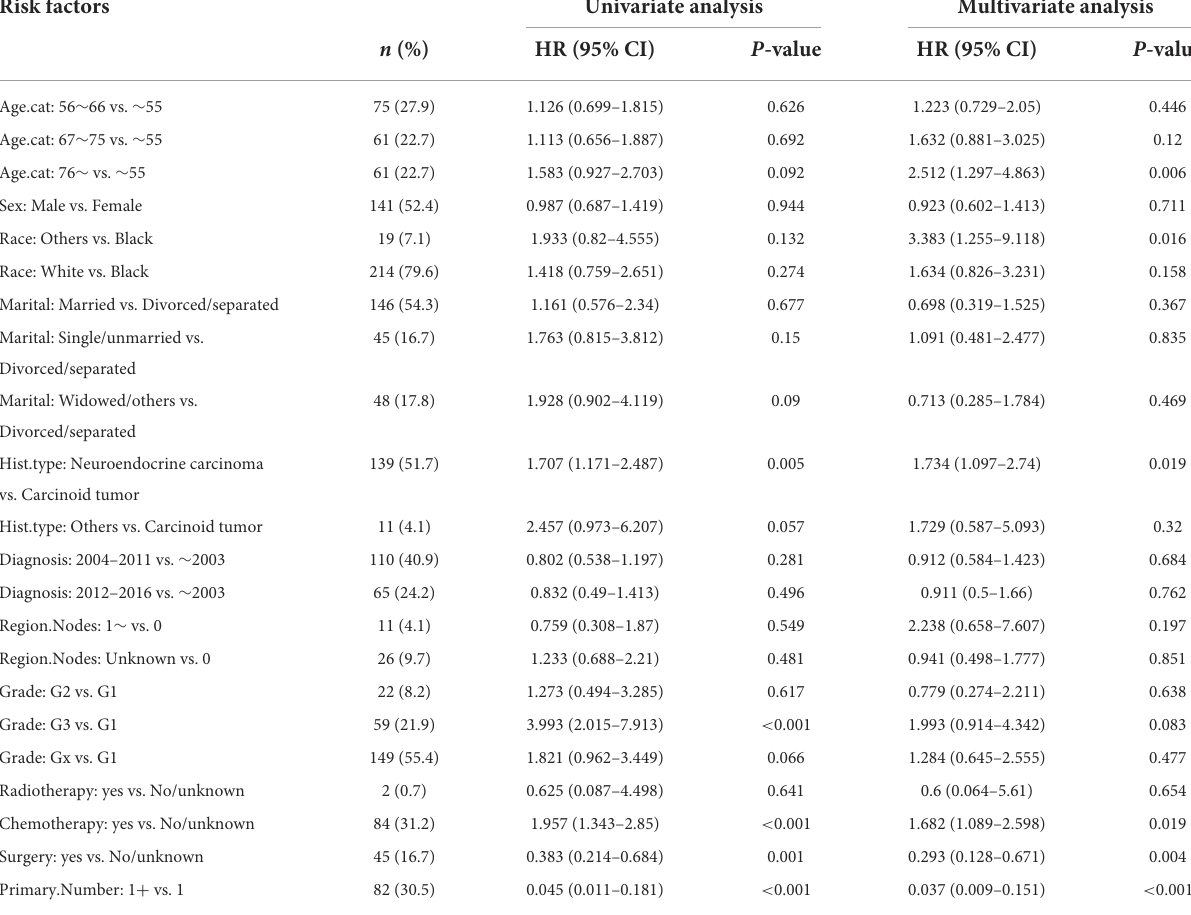
TABLE 3 Univariate and multivariate Cox analysis of factors for DSS in patients with PHNET in the validation set. Risk